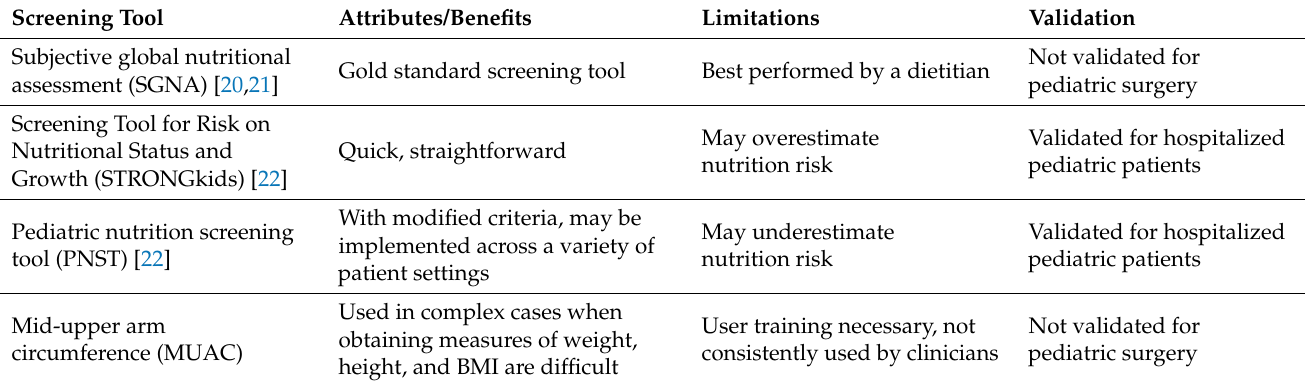
Table 1. Potential Nutrition Screening Tools Applicable to Pediatric Patients Undergoing